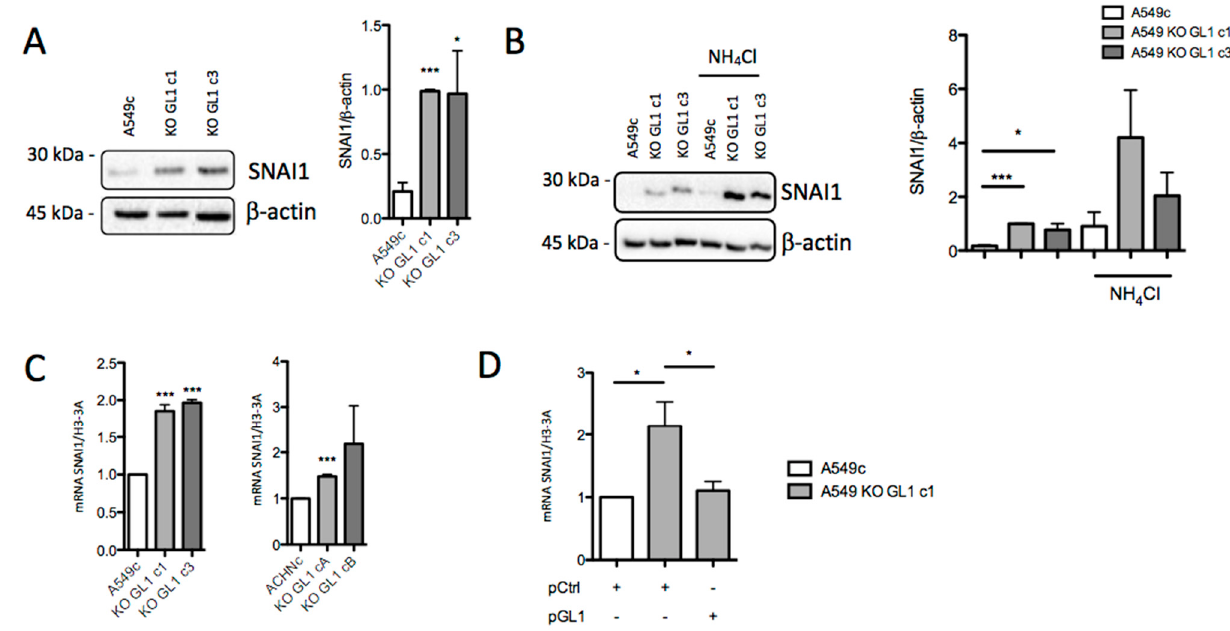
Figure 5. GABARAPL1 knockout leads to an increase in SNAI1 levels. ( A ) Western blotting analysis of SNAI1 levels in untreated A549c and KO GABARAPL1 cells. ( B ) Western blotting analysis of SNAI1 levels in A549c and KO GABARAPL1 cells untreated or treated with 50 mM NH 4 Cl for 2 h. β -actin was used as a loading control. Protein levels were quantified using Image Lab. Data are represented as the mean ± S.E.M. of at least five independent experiments; p * < 0.05 compared to the control; p -values were calculated using Student’s t -test. ( C ) mRNA levels of SNAI1 were measured by qRT-PCR in untreated A549c, ACHNc, and KO GABARAPL1 cells. The values calculated by the ∆∆ CT method are relative to H3-3A levels, and are expressed as fold change. Data are represented as the mean ± S.E.M. of three independent experiments; p * < 0.05 compared to the control; p -values were calculated using Student’s t -test. ( D ) mRNA levels of SNAI1 in A549c cells transfected with pCDNA_Control (pCtrl) or A549 KO GL1 c1 cells transfected either with pCtrl or pCDNA-Flag- GABARAPL1-6His (pGL1). The values calculated by the ∆∆ CT method are relative to the levels of H3-3A, and are expressed as fold change.